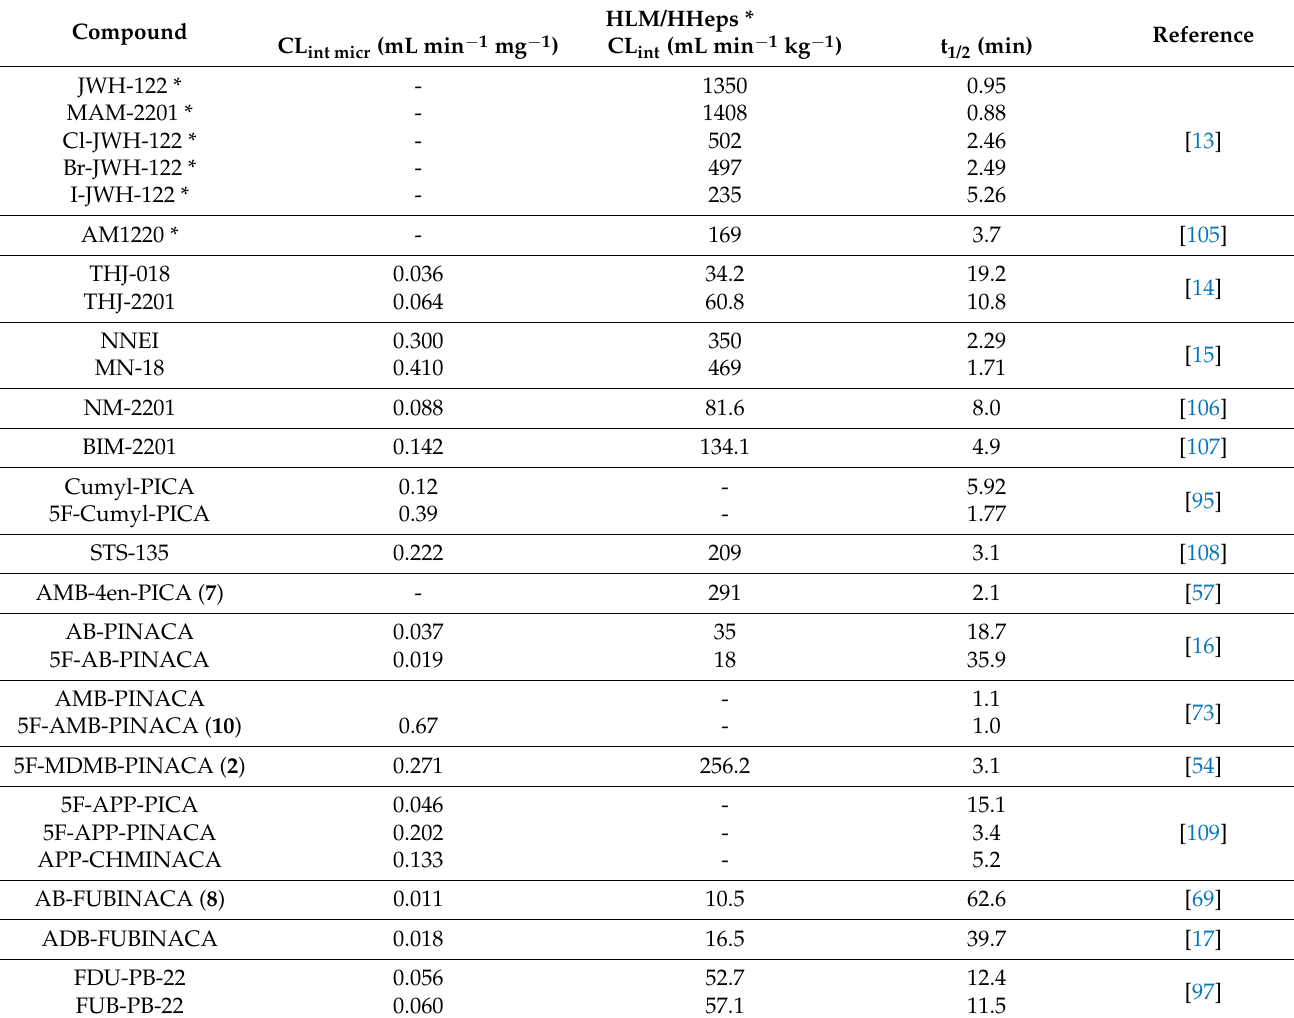
Table 6. Literature values for intrinsic clearance (CL int ) rates and half-lives (t 1/2 ) of SCRAs in human liver microsomes (HLM) and human hepatocytes (HHeps). Compounds marked with an asterisk (*) display pHHep data; all other data is from pHLM incubations. HLM/HHeps Compound